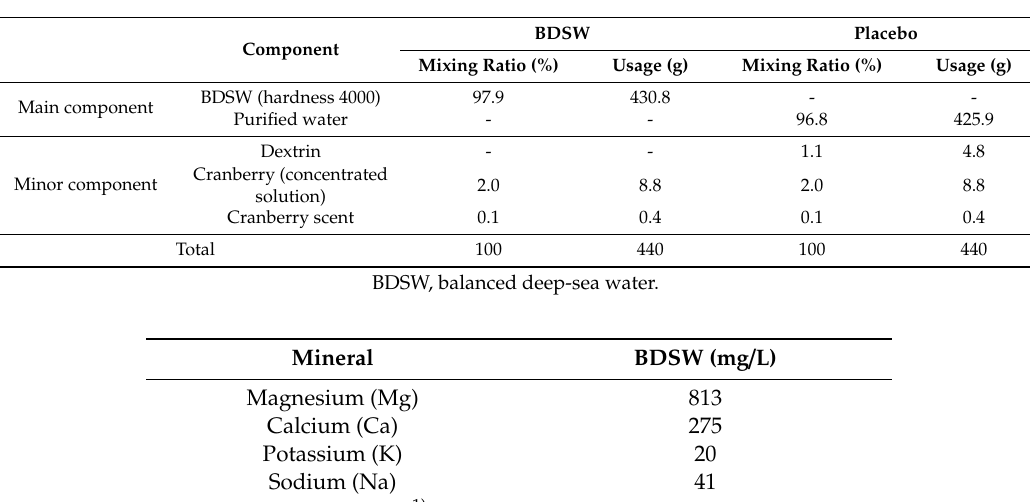
Table 1. Content of product and placebo (top) and mineral content of the balanced deep-sea water (BDSW) at a hardness of 4000 (bottom).